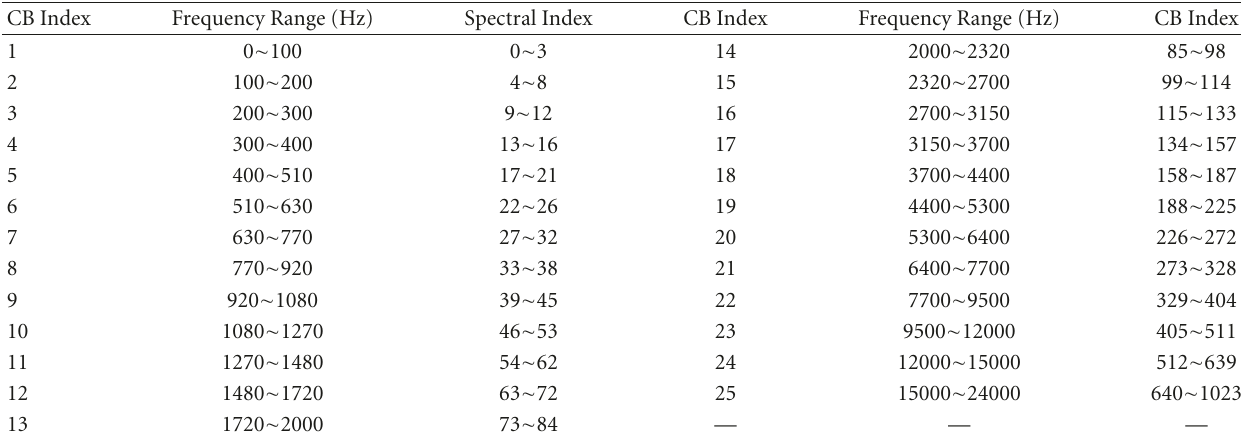
Table 2: Critical Bands for 2048-point DFT, sampling frequency 48 kHz